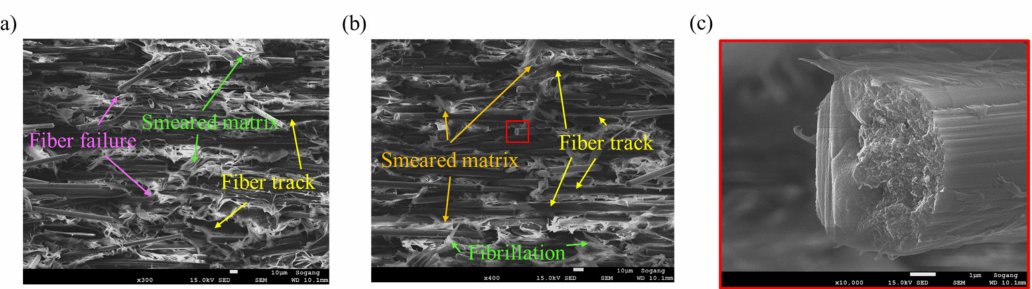
Figure 15. Fracture mechanisms observed for θ = 90 ◦ compressive specimen: ( a ) fiber failure, smeared matrix, and fiber tracks (magnification: × 300, scale: 10 µ m), ( b ) fiber tracks and fibrillation (magnification: × 400, scale: 10 µ m), ( c ) fracture face of the fiber after flexural failure (magnification: × 10,000, scale: 1 µ